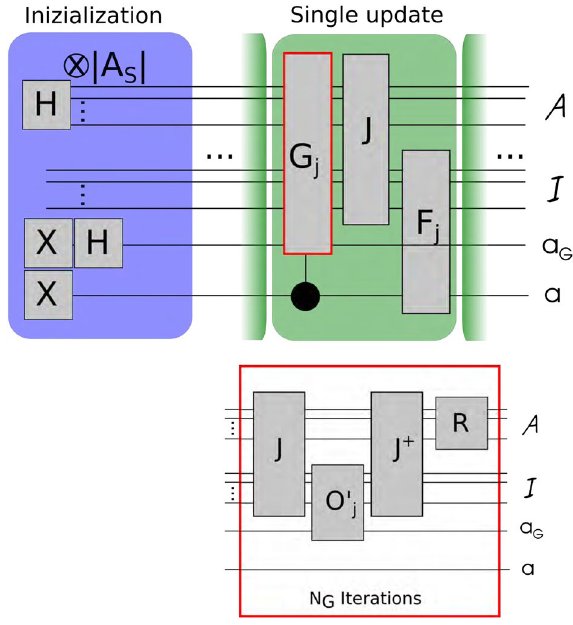
Figure 2. Quantum routine. Schematic representation of the quantum routine for the update of a classical probability distribution on the quantum register. After the initialization of the register the J performed to store the values of the probability distribution for each of the J classes for each state s . It shows also the single iteration of the modified Grover